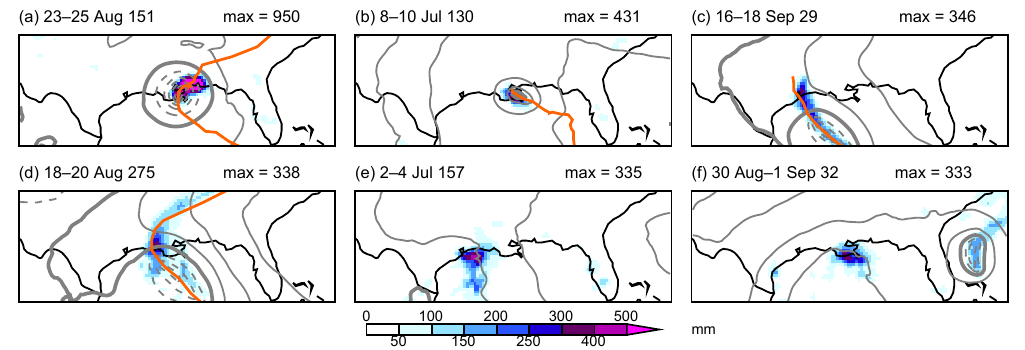
Figure 10. The same as Fig. 8 but now for the top six maximum extreme precipitation events in the 1990 HiFLOR static forcing experiment. Note that years are model years and do not resemble dates on the real-world calendar and that the model provides precipitation information over ocean grid boxes